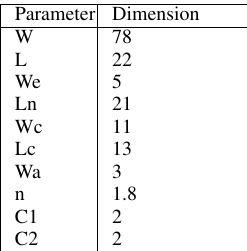
TABLE 1: The optimized parameters value of the studied RFID tag antenna in millimeter (mm).